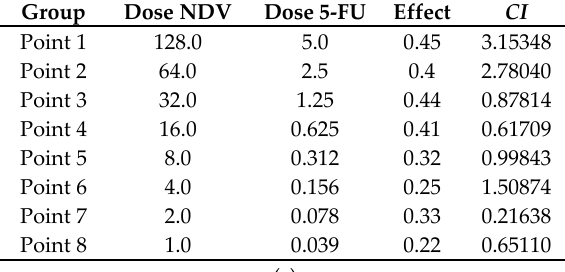
Figure 3. Combination cytotoxicity on AMN3 cells. ( a ) The cytotoxic effect of 5-FU, NDV, or both, on AMN3 cell proliferation. The cells were treated with 5-FU (5 µg in two-fold serial dilutions up to 0.039 µg/mL), NDV (128 HUA with two-fold serial dilutions) or a combination of the two. The results for the treated groups are expressed as the cell proliferation rate compared to untreated control cells grown at identical conditions; ( b ) isobologram analysis shows the synergism between NDV and 5-FU at the highest five doses and antagonism at three doses (point 1 and 2 value above 2 and for that will not be shown in the figure limits as they considered as extremely antagonized); and ( c ) table showing the combination index data for each dose of the combination points used.